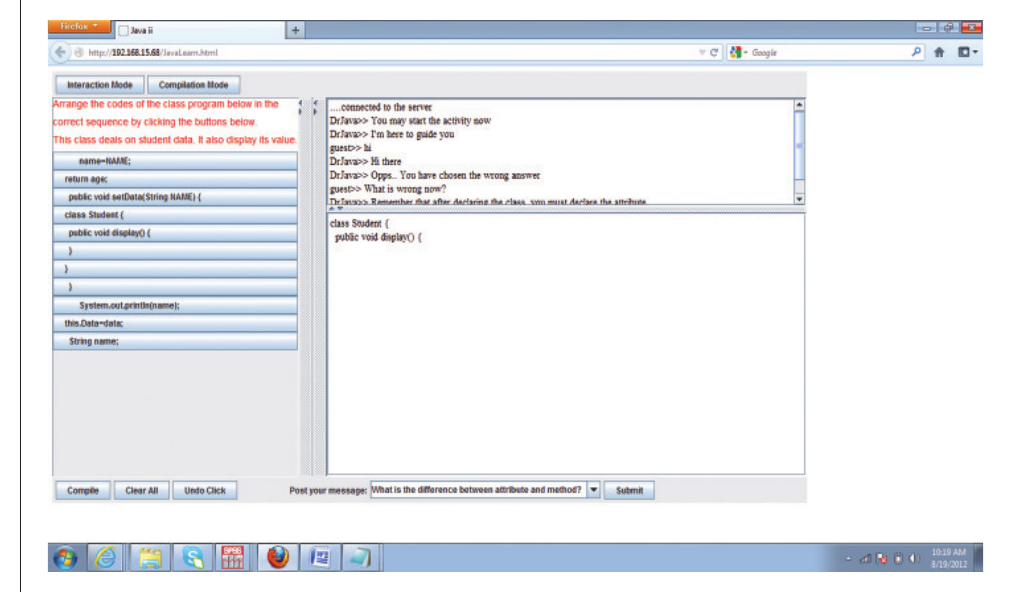
Figure 5 A segment of interactions in JavaLearn between the student ( guest ) and the agent ( DrJava